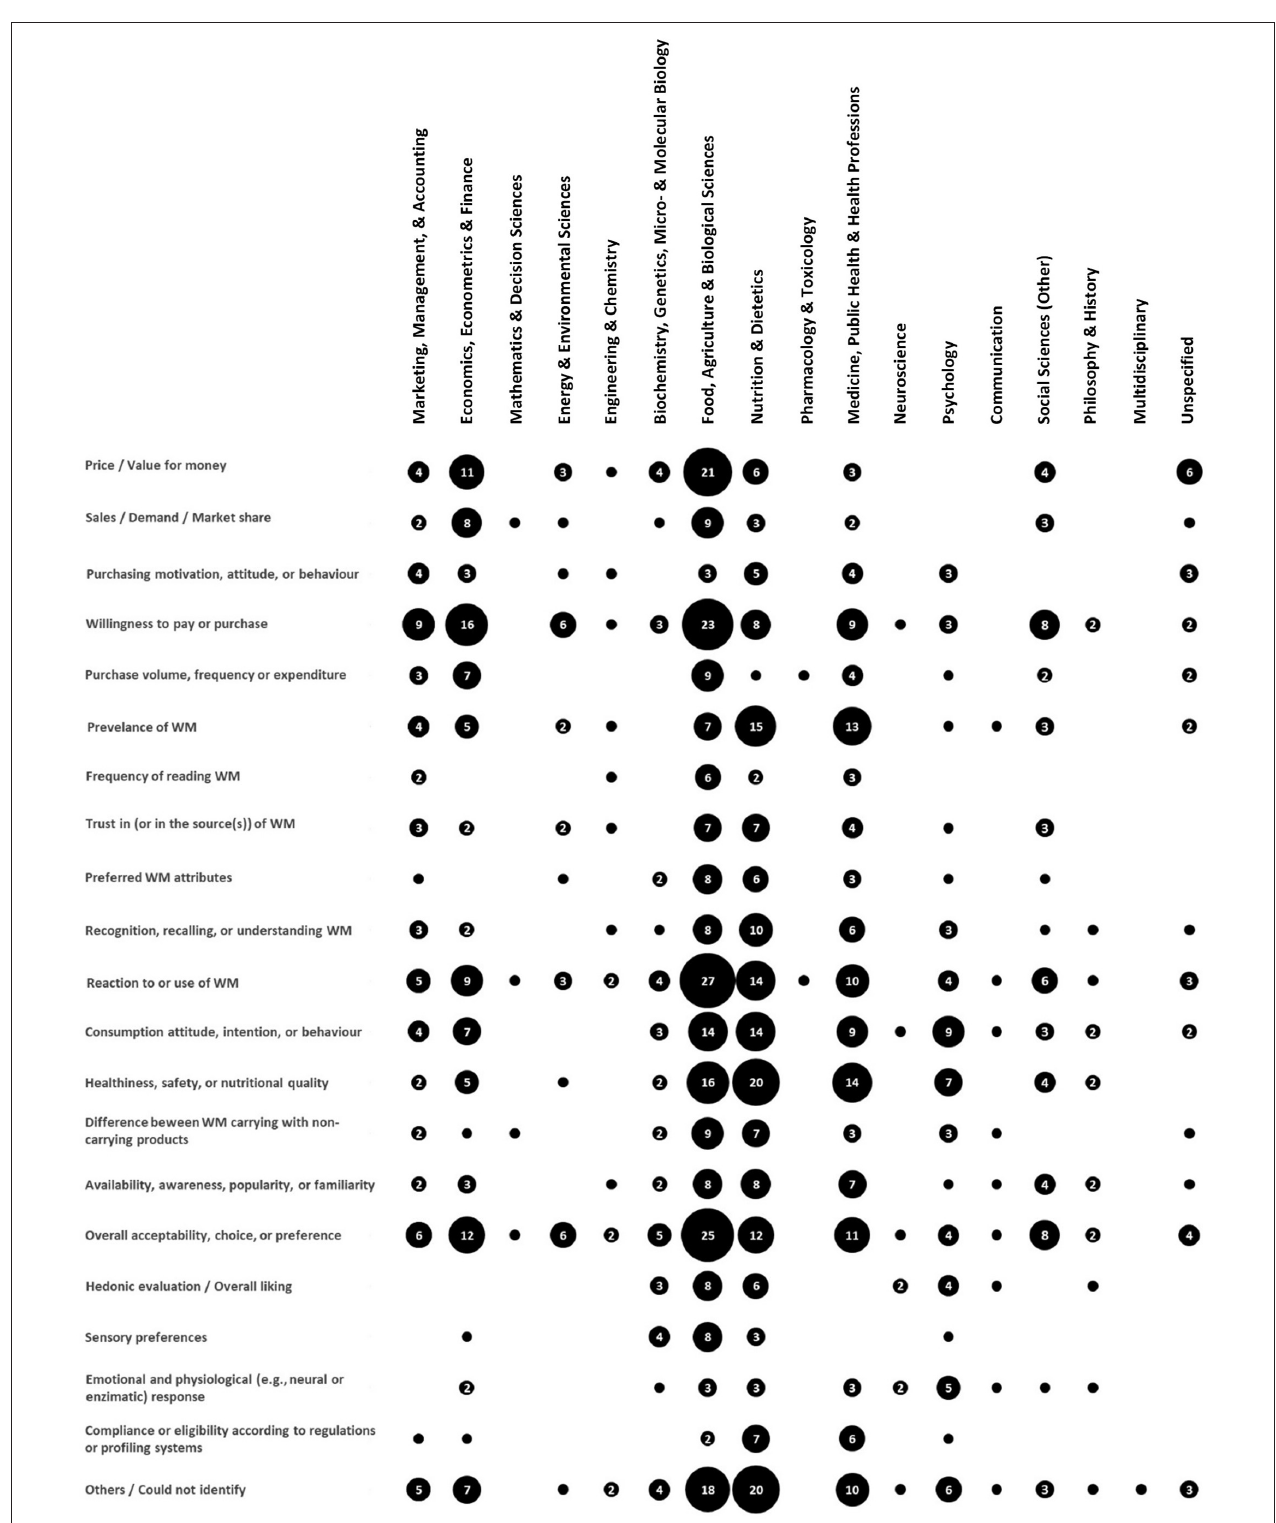
FIGURE 14 | Prevalence of particular outcomes of empirical interest in each discipline. Numbers in bubbles specify the prevalence. Note that bubbles with no number represent only one record.